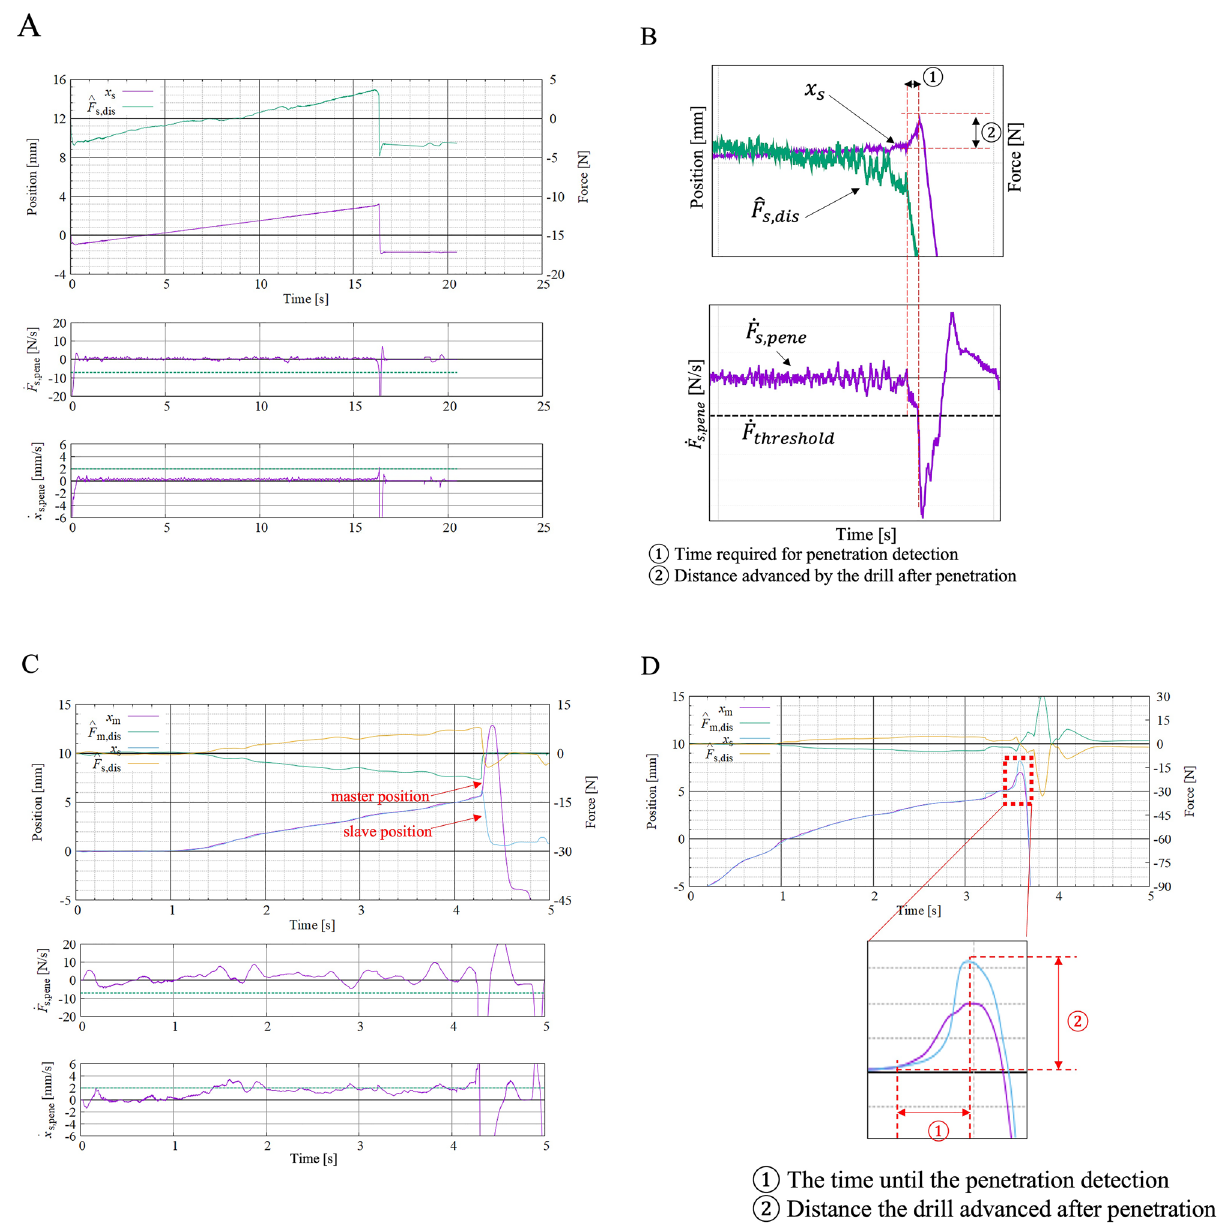
Figure 4. Position and force–time waveform of the master and slave units on the haptic drill. ( A ) The distance the drill advanced after penetration was defined as the distance that the slave advanced before the device detected the penetration and started retracting the drill. ( B ) This is a magnified view of the waveform, especially during penetration. The horizontal axis shows time, and the vertical axis shows reaction force. The waveforms are magnified to emphasize the changes in the waveforms during penetration. ① Shows the time required for penetration detection. ② Shows the distance advanced by the drill after penetration. ( C , D ) The distance travelled after penetration was defined as the distance travelled from "the position where the drill started to move forwards rapidly" to "the peak of the drill (slave) position", i.e., the distance travelled until the surgeon detected the penetration and started to retract the drill body. ① shows the time required for penetration detection. ② shows the distance advanced by the drill after